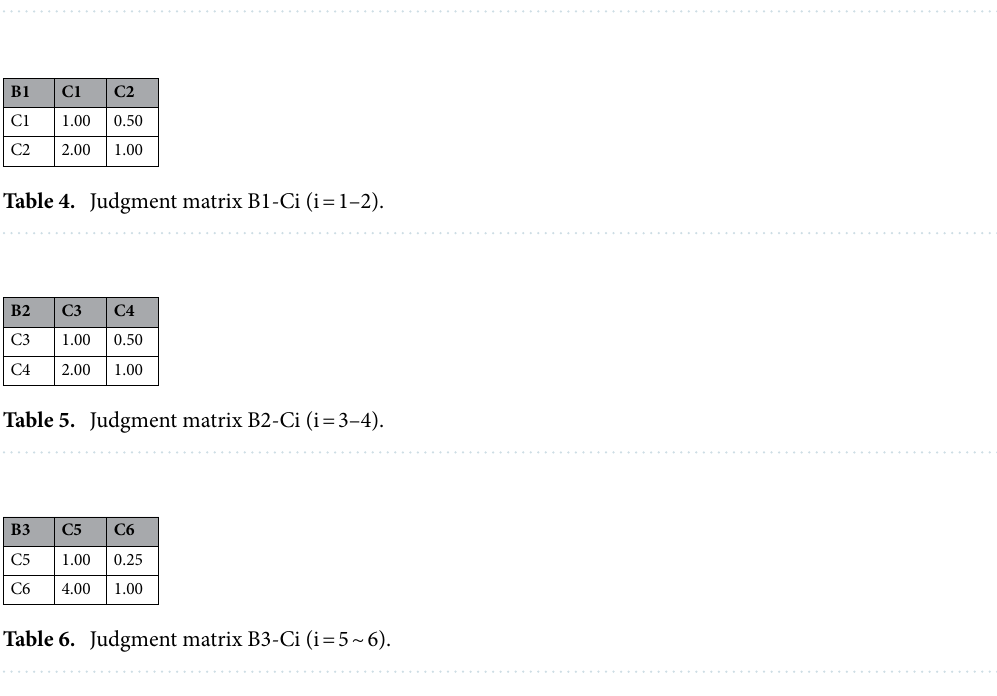
Table 3. Judgment matrix A-Bi (i = 1–4).